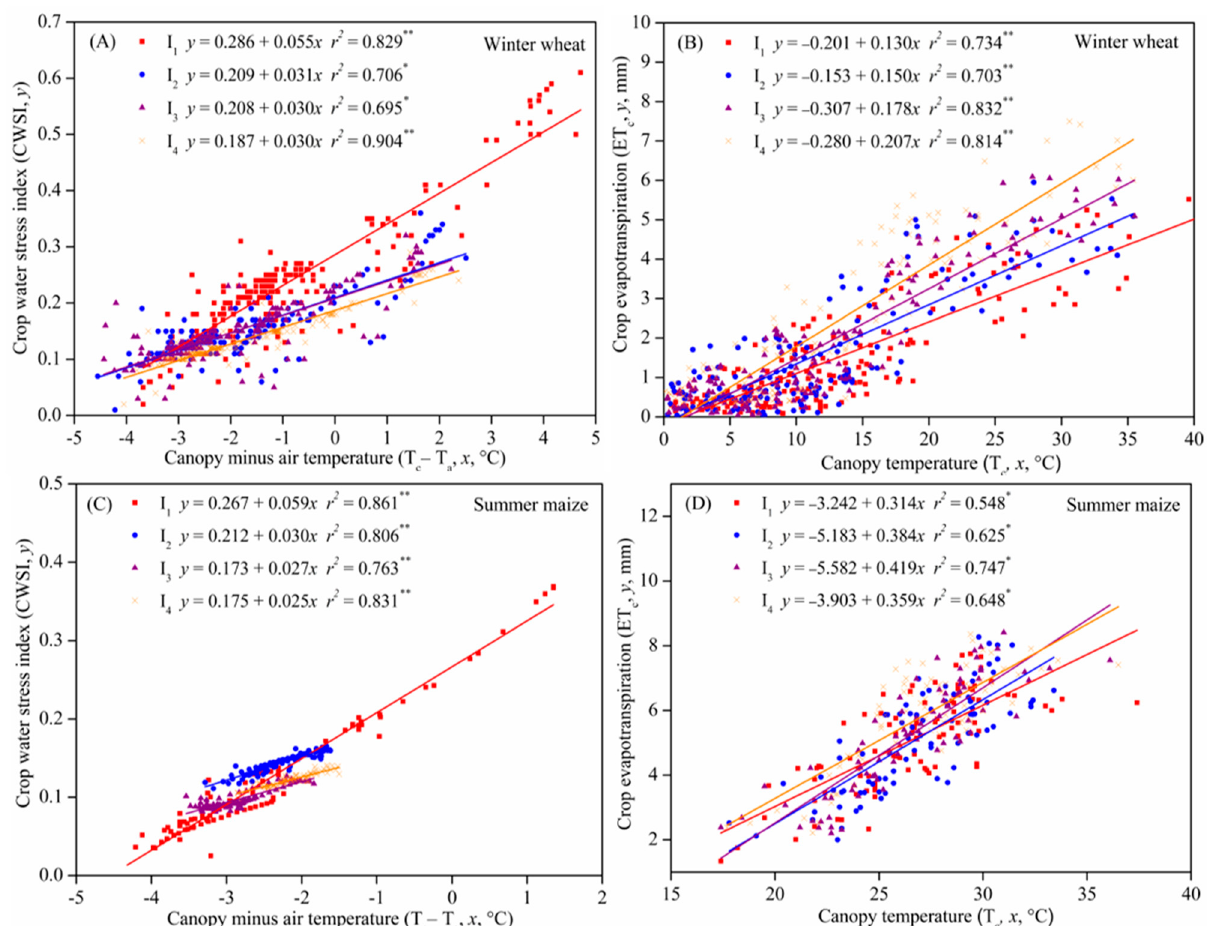
Figure 7. Positive linear equations fitted to the relationships ( A , C ) between crop water stress index (CWSI, y) and canopy minus air temperature (T c − T a , x), and ( B , D ) between crop evapotranspiration (ET c , y) and canopy temperature (T c , x) based on field experiments conducted in the 2019–2020 growing season. * and ** mean significant correlation at p < 0.05 and p < 0.01, respectively.